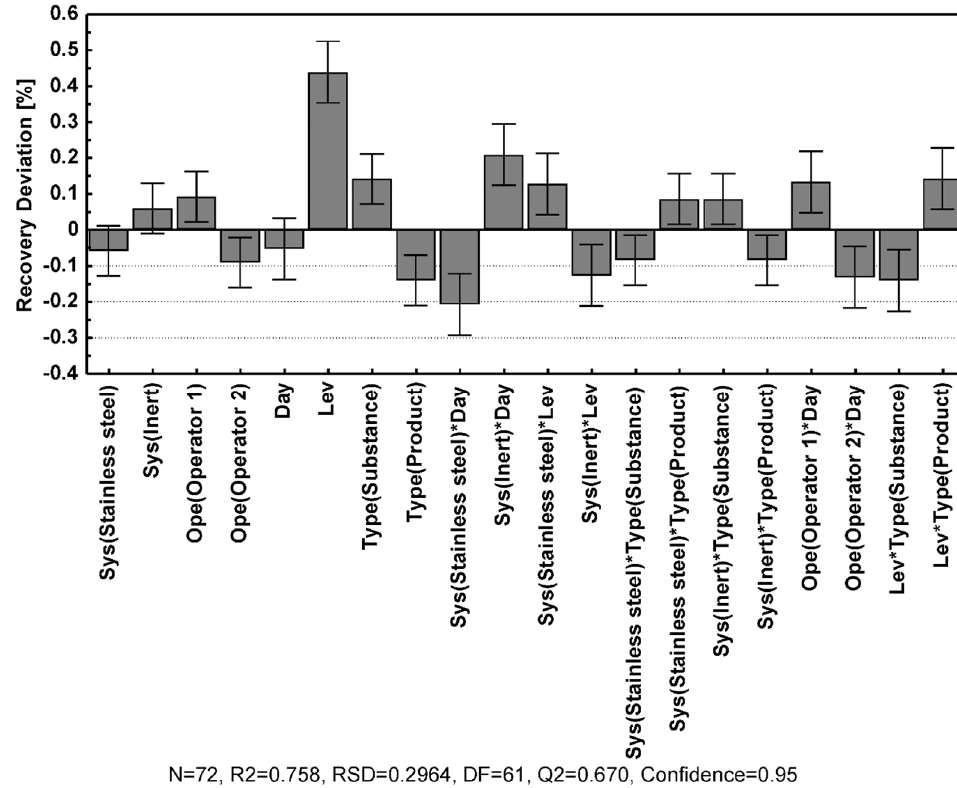
Figure 6. Coefficient plot for the autotune model of the correlation between recovery and analysis conditions. The boxes indicate the relative impact of the coefficient on the model, while the whiskers show the uncertainty of the coefficient value, and consequently, if the uncertainty exceeds the value, that coefficient will be considered insignificant. The star (*) indicates interaction terms between different variables.